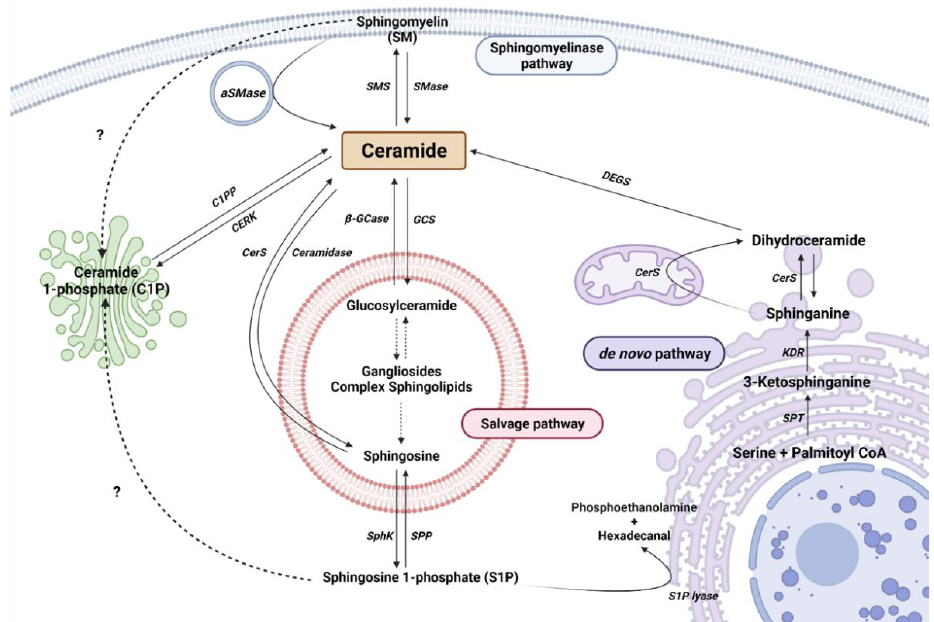
Figure 1. Sphingolipid metabolism. Single reactions are represented by solid arrows, while multiple-step reactions are shown as dashed arrows. Interrogation marks with dashed arrows point to possible mechanisms not yet described. Serine palmitoyltransferase (SPT), 3-keto-dihydrosphingosine reductase (KDR), ceramide Synthase (CerS) and dihydroceramide desaturase (DEGS), sphingomyelinase (SMase), acid sphingomyelinase (aSMase), sphingomyelin synthase (SMS), acid β -glucosidase (β -GCase), glucosylceramide synthase (GCS), ceramide synthase (CerS), sphingosine ki- nase (SphK), and sphingosine 1-phosphate phosphatase (SPP) are represented by their acronyms.